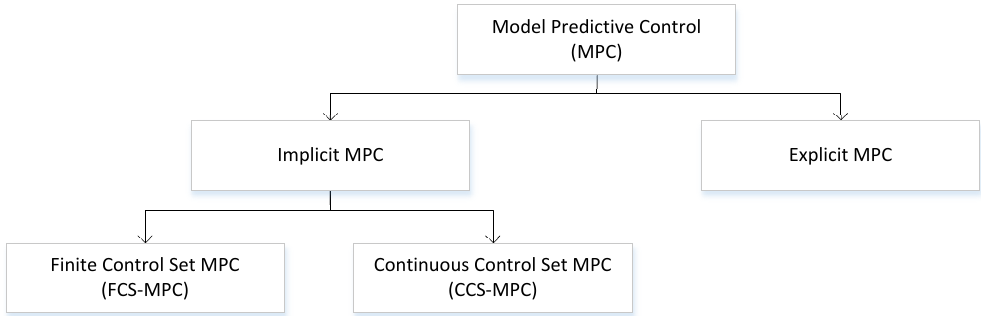
Figure 2. Types of model predictive